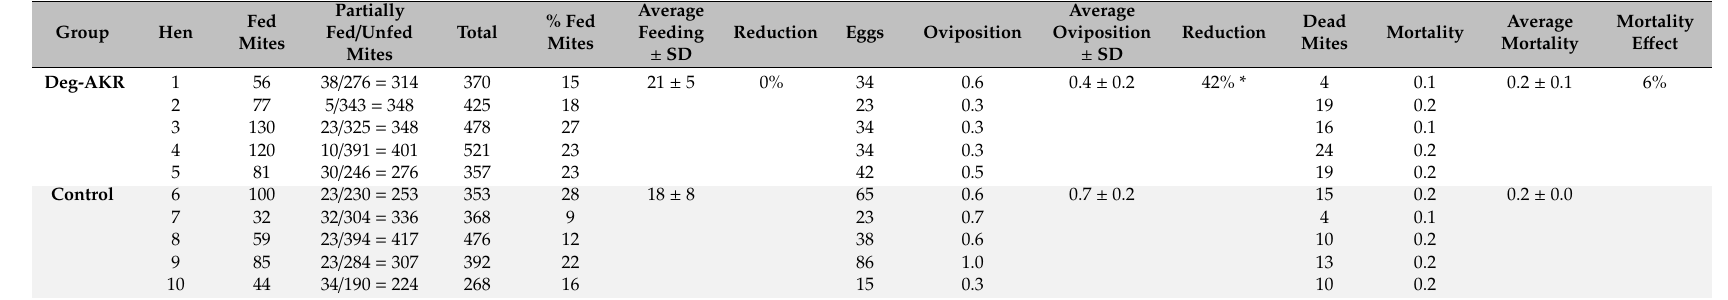
Table 1. Summary of adult female PRM feeding rates and vaccine e ffi